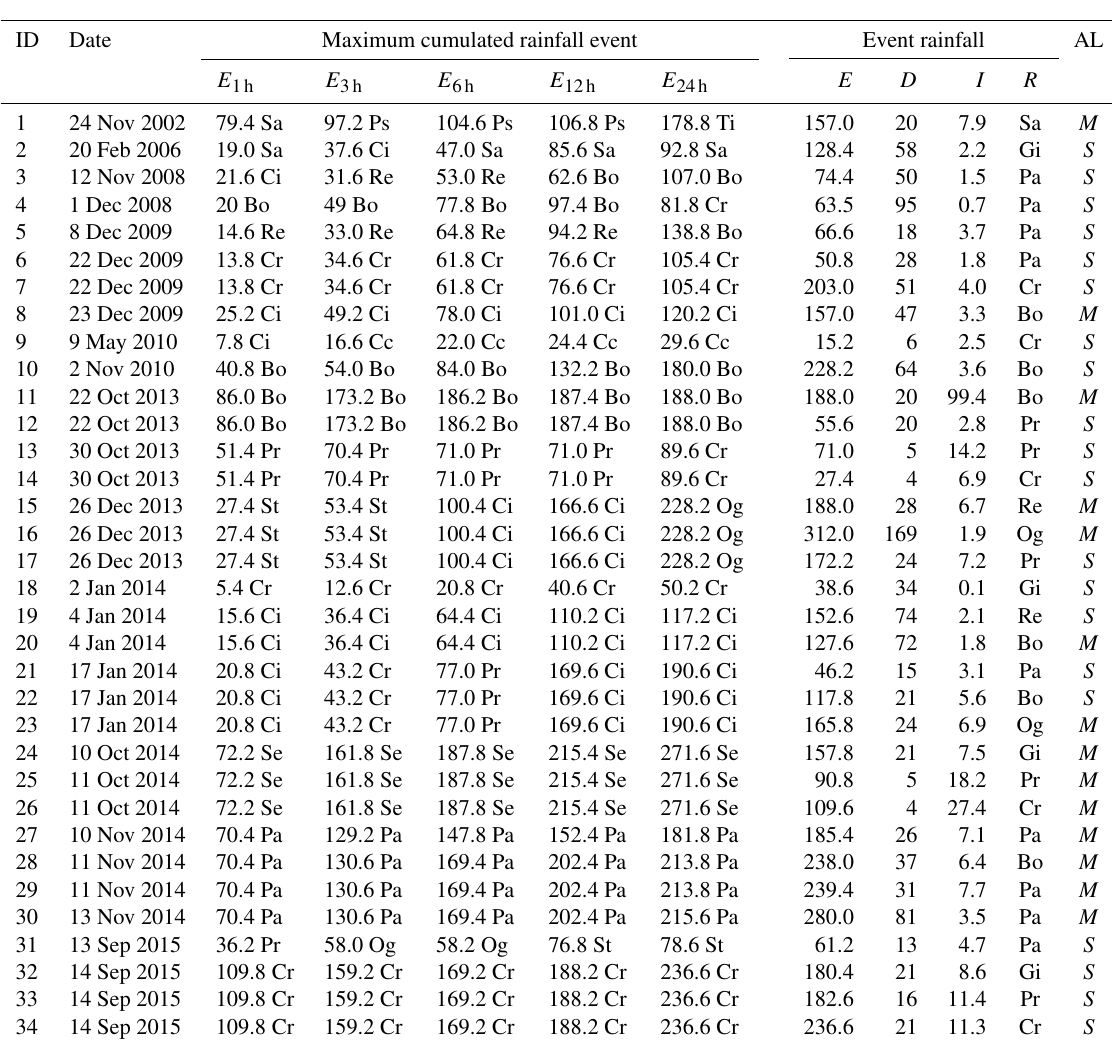
Table 3. Rainfall conditions used to define the rainfall threshold for the possible initiation of shallow landslides in the Entella catchment. Rain gauges ( R ): Bo – Borzone; Ci – Cichero; Cc – Chiavari Caperana; Cr – Croce di Orero; Gi – Giacopiane Lago; Md – Monte Domenico; Og – Ognio; Pa – Panesi; Ps – Piana di Soglio; Pr – Pian dei Ratti; Re – Reppia; Se – Sella Giassina; Sa – San Michele; Sm – San Martino del Monte; St – Statale; Ti – Tigliolo. See Fig. 1 for location of the rain gauges. E ∗ h , maximum cumulated rainfall recorded in the catchment, for different periods (mm). Rainfall measures that have resulted in landslides: E – cumulated rainfall event (mm); D – event rainfall duration (h); I – event rainfall intensity (mmh − 1 ). Abundance of landslides (AL): S – single landslide; M – multiple landslides.